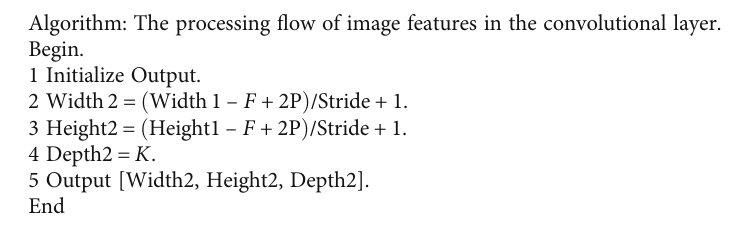
Algorithm 1: The processing fl ow of image features in the convolutional